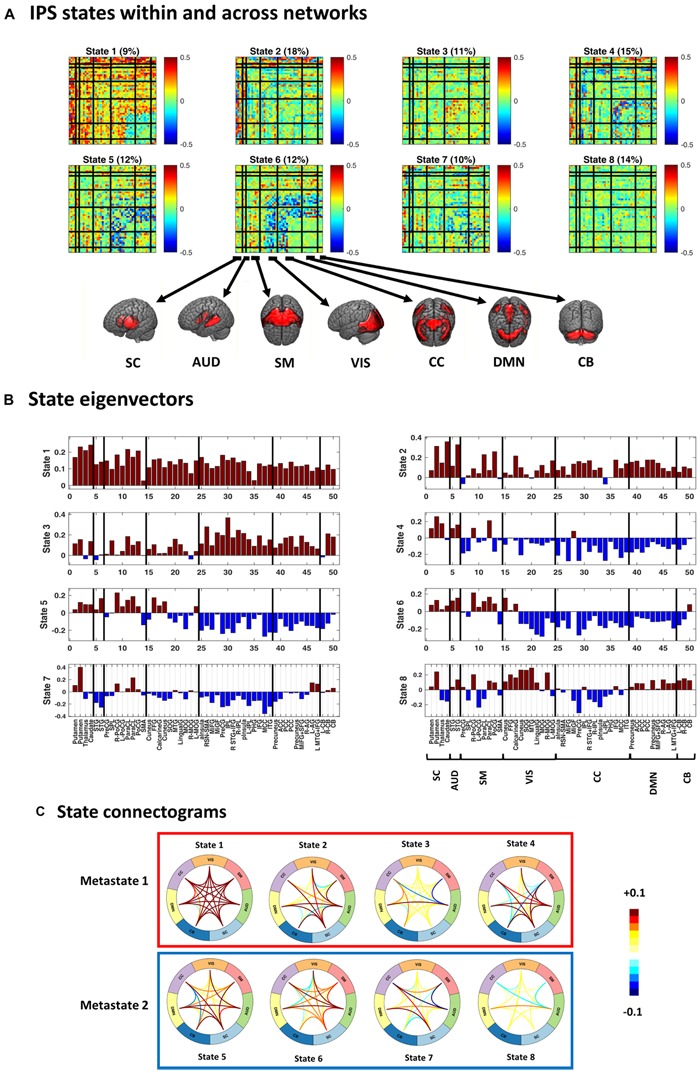
Instantaneous phase synchrony (IPS) states, in three representations. (A) Eight cluster centroids, depicted in matrix format. Each centroid stands for an IPS state. The relative expression of each state (across time and subjects) is printed above it. Surface colors reflect IPS values (Eq. 3). Matrix representation offers a detailed account of the phase coupling structure of each state, within and across seven functional networks. (B) The first eigenvector of each state is presented as a bar plot. Positive and negative entries constitute two detached communities. (C) State connectograms are concise representations of average inter-network phase couplings, where the average is taken over sub-components of each network. For instance, the central role of the subcortical (SC) network in state 2 is readily recognized by noting the warm colored arcs extending from SC to other networks. SC, subcortical; AUD, auditory; SM, somatomotor; VIS, visual; CC, cognitive control; DMN, default mode network; CB, cerebellum. For the sub-network abbreviations, please refer to the caption of Figure 2.